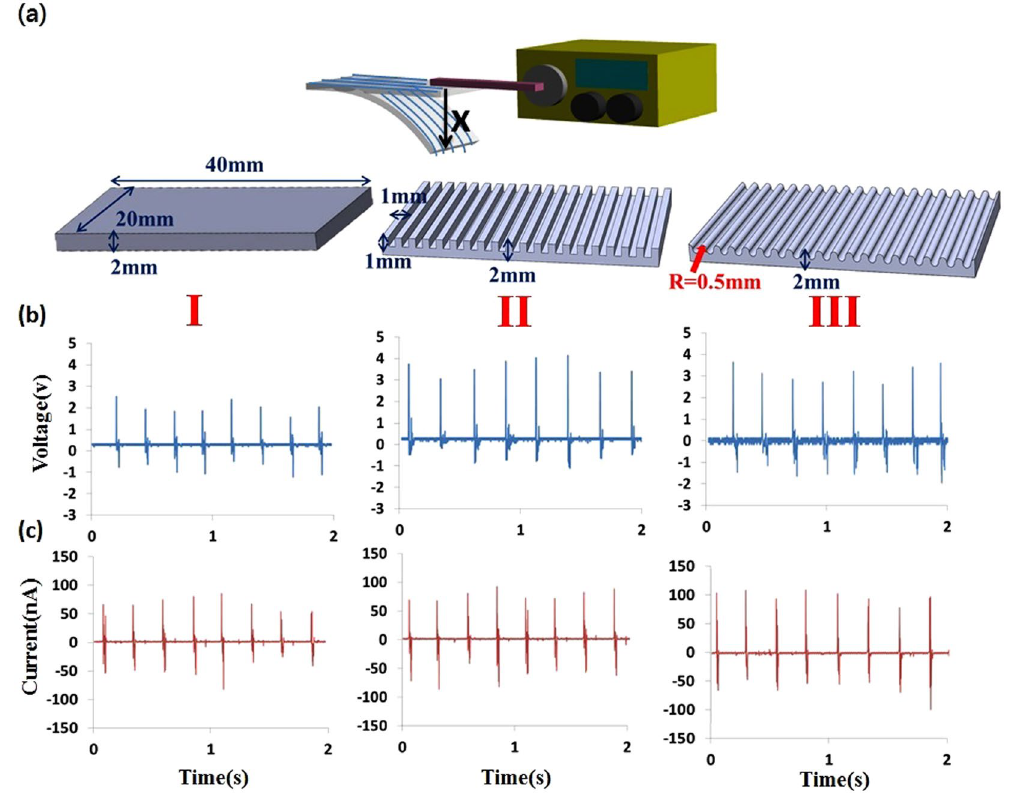
Figure 2. ( a ) Schematic of the experimental setup and three topologically different surfaces were investigates as: planar surface (I), square surface (II) and sinusoidal surface (III). ( b ) Output voltage and ( c ) current versus stretching-releasing deformation strain of 0.5% at 4 hz. The topologically tailored devices (I/II/III) can stably produce about average output voltage 2 V/3.5 V/4 V and output current 50 nA/70 nA/100 nA, respectively during the cyclic